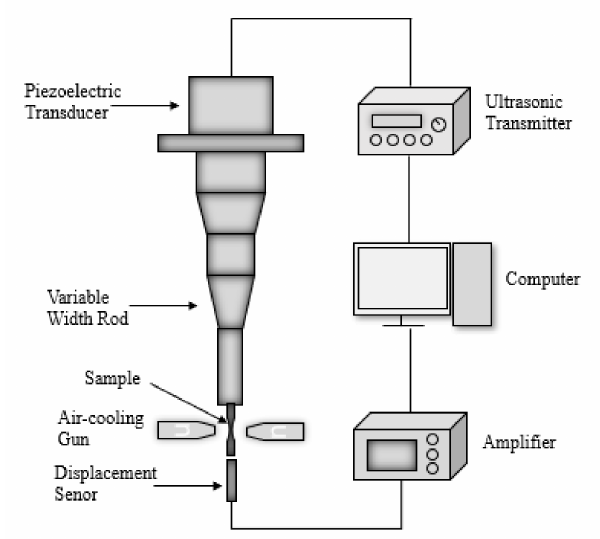
Figure 3. Principle diagram of the ultrasonic fatigue testing equipment. The fatigue specimen is fixed at one end of the displacement amplifier, and the mechanical vibrations generated by the piezoelectric transducer are increased to the required amplitude for fatigue loading through the displacement amplifier, causing the specimen to resonate at 20 kHz. The output displacement of the amplifier is measured by a dynamic displacement transducer.